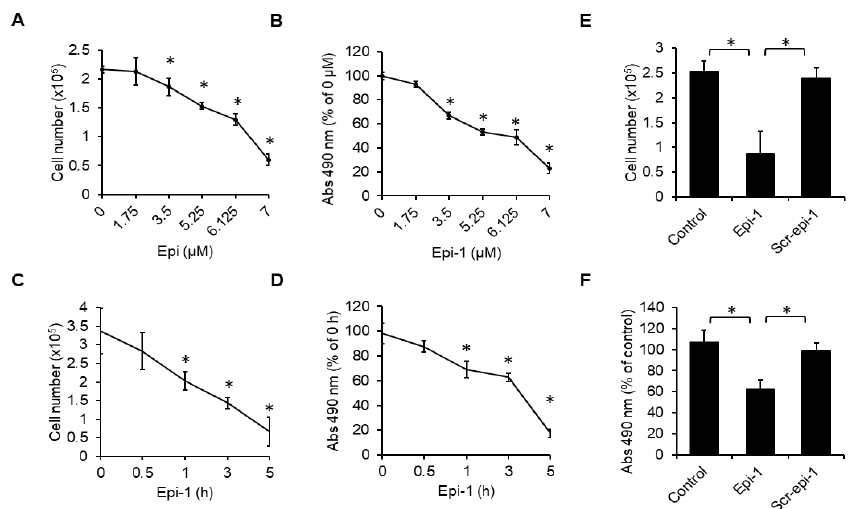
Figure 1. Cytotoxicity of epinecidin-1 (epi-1) on human synovial sarcoma cells. SW982 cells were treated with indicated doses of epi-1 for 5 h. Cytotoxicity was analyzed by the trypan blue exclusion assay ( A ) and MTS / PMS assay ( B ). Cells were treated with epi-1 (6.125 µ M) at di ff erent time points (0.5, 1, 3, 5 h). Cytotoxicity was analyzed by the trypan blue exclusion assay ( C ) and MTS / PMS assay ( D ). Cells were treated with epi-1 (6.125 µ M) or scrambled epi-1 (scr-epi-1) (6.125 µ M) for 5 h, and cytotoxicity was determined by the trypan blue exclusion assay ( E ) and MTS / PMS assay ( F ). * p < 0.05 was considered significant. Int. J. Mol. Sci. 2020 , 21 , x FOR PEER REVIEW